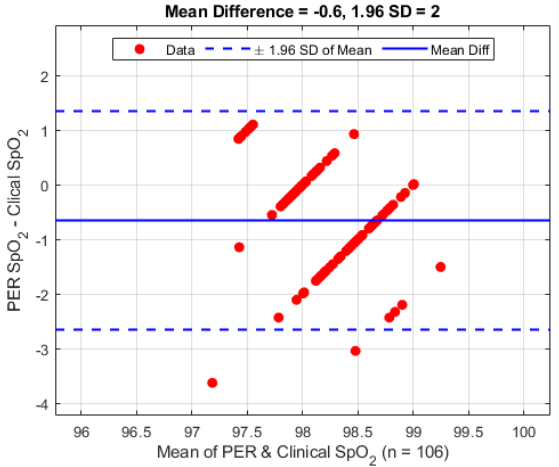
Figure 9. Bland–Altman analysis of SpO 2 from the periphery sensor vs. the clinical monitor.